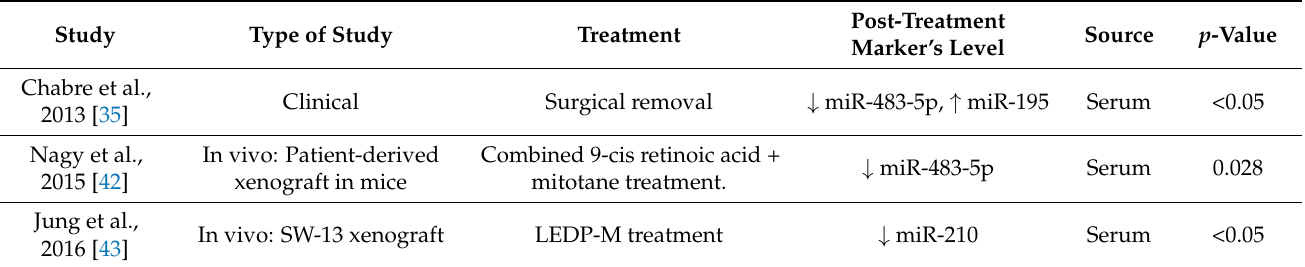
Table 4. miRNAs as therapeutic biomarkers for ACC.